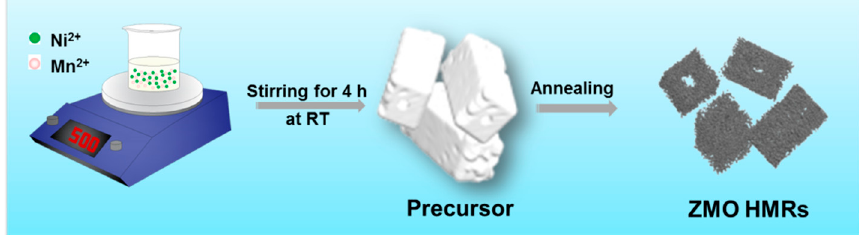
Scheme 1. Schematic illustration for the formation of porous ZMO HMRs.